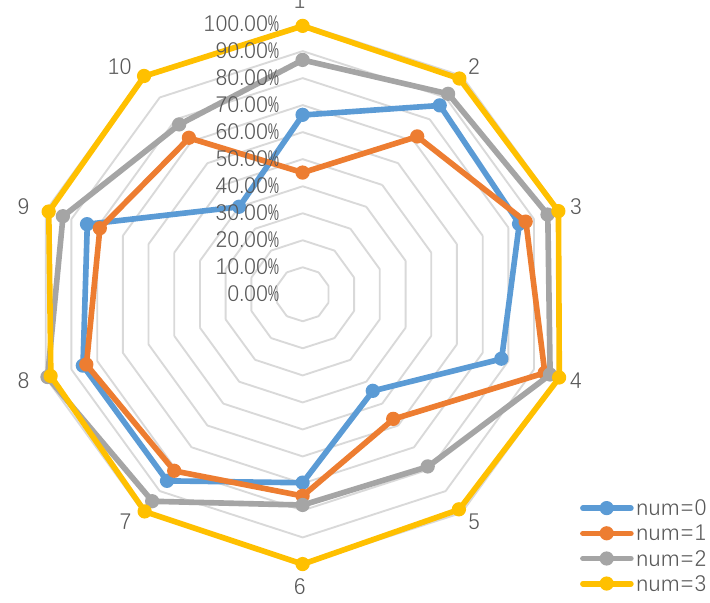
Figure 8. 10-fold cross-validation accuracy of DTW. Table 2. 10-fold cross-validation accuracy.